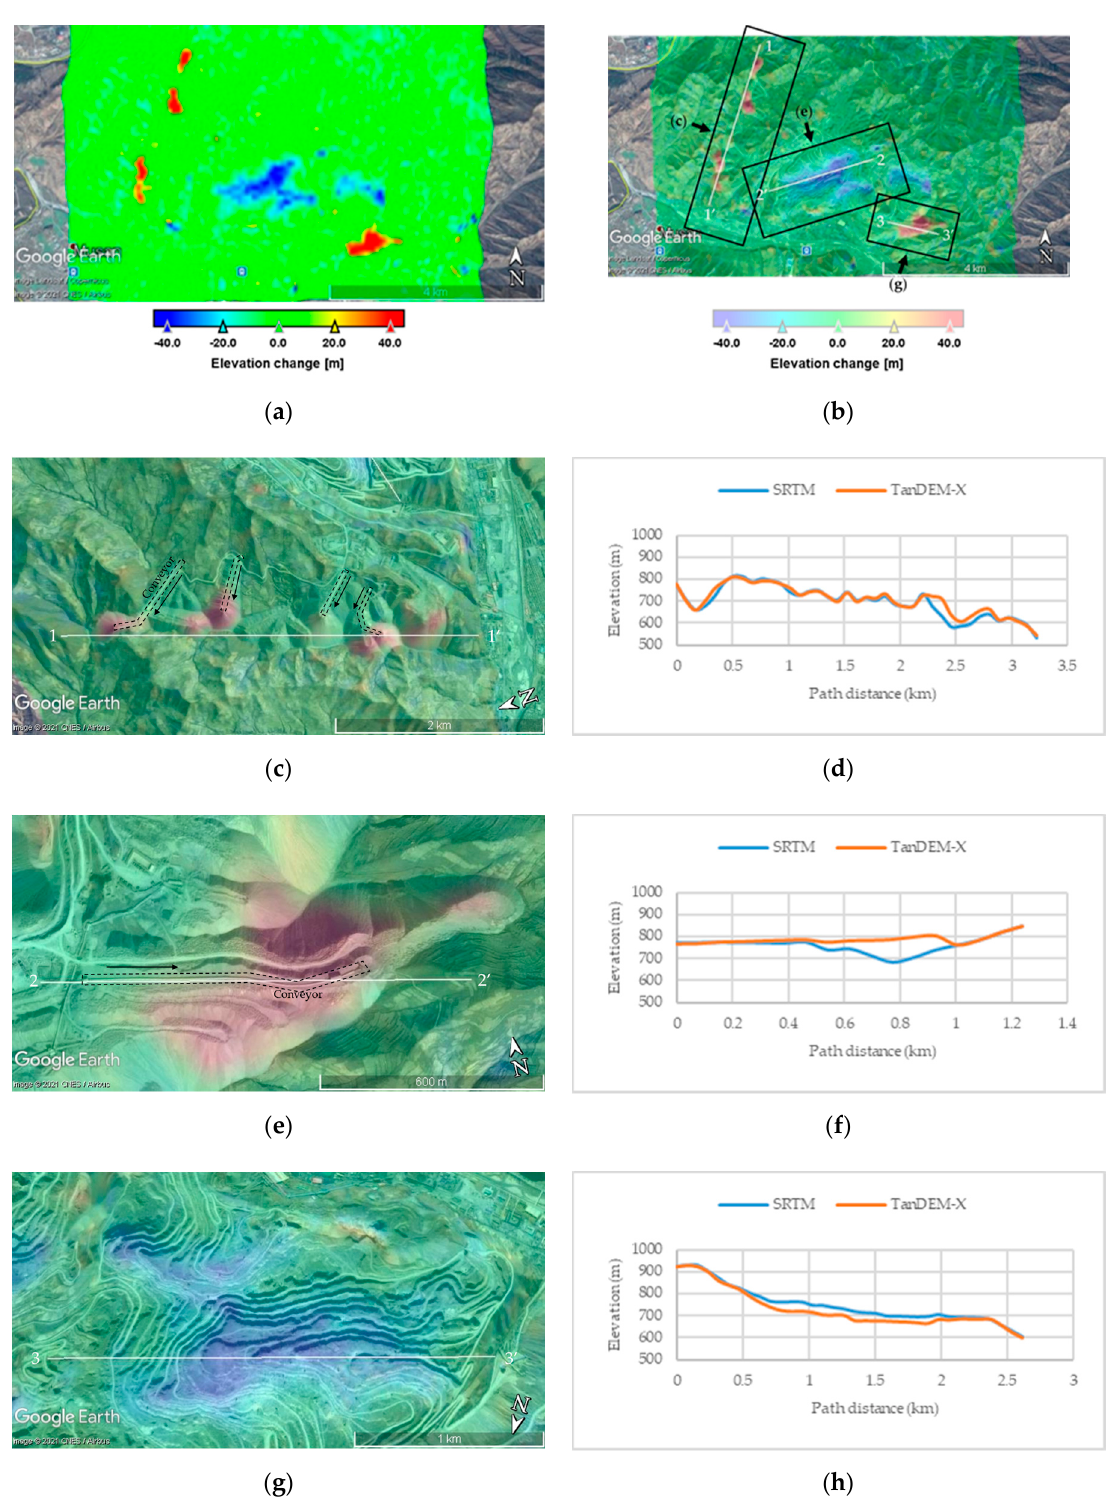
Figure 9. The InSAR DEM change results. ( a ) is the change in DEM from SRTM DEM (2000) to TanDEM-X DEM (2010–2015). ( b ) is an index map showing the profile lines created in the dumping areas and excavation site overlain by Google Earth, 16 October 2013 image. ( c , d ) represent the elevation change in the west dumping area. ( e , f ) represent the elevation change in the east dumping area. ( g , h ) represent the elevation change in the excavation site.